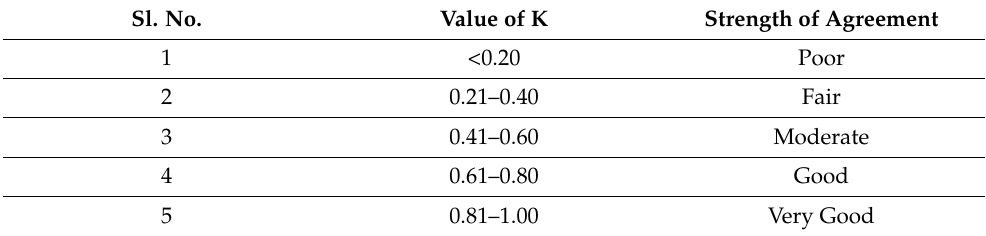
Table 2. Scale of the kappa coefficient and strength of agreement. Sl.